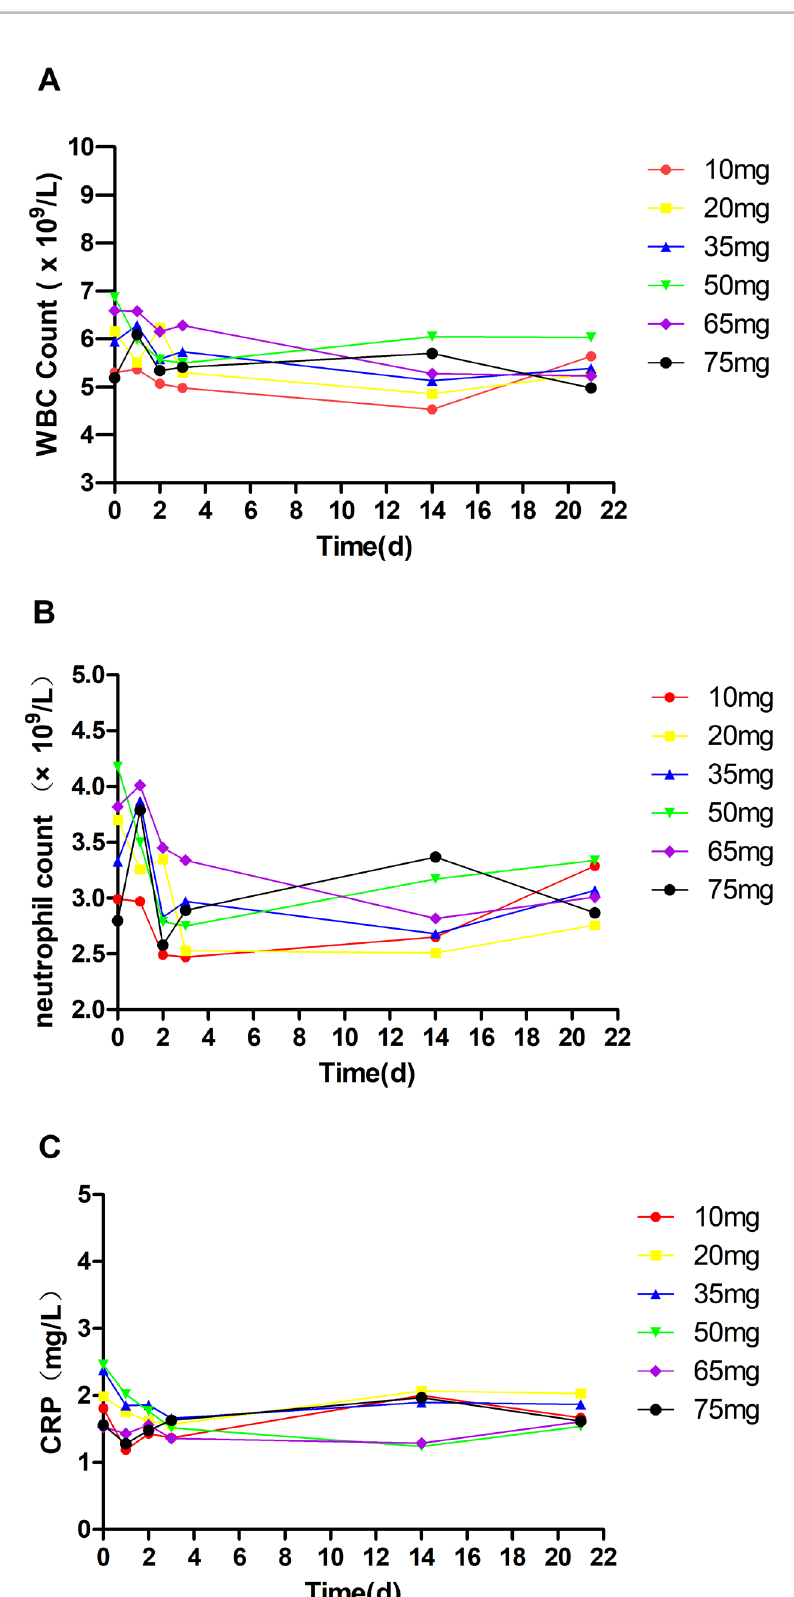
FIGURE 1 - Changes detection in the value of laboratory parameters after single dose subcutaneous administration of T0001 in healthy subjects in each of the follow-up period (day 0, day 1, day 2, day 3, day 14 and day 21). (A). WBC count; (B.) Neutrophil count; (C). CRP; WBC = white blood cell, CRP = C-reactive